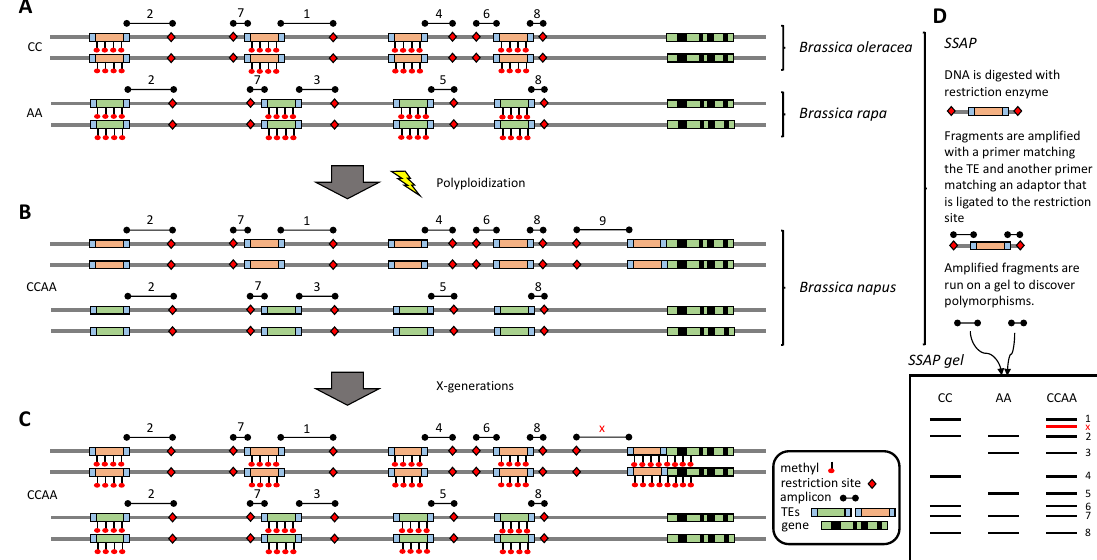
Figure 2. Allopolyploidization and its effects on TE epigenetic regulation. The diagram shows the hypothetical outcome of a cross between the diploid genomes of Brassica oleracea (CC genome) and Brassica rapa (AA genome) to produce an allotetraploid ( Brassica napus —CCAA genome). ( A ) Homologous DNA regions of the parent genomes contain four TEs and one gene; the regions present some divergence due to speciation; ( B ) After polyploidization a tetraploid is formed ( B. napus ) and methylation is transiently suppressed, allowing TEs to move to new genomic locations. In this example just one TE moves to the promoter region of the depicted gene of the CC subgenome; ( C ) After a variable number of generations methylation is reinstated and the novel TE insertion silences the gene in the CC subgenome, but the homeologous gene in the AA subgenome expresses normally; ( D ) In the original experiment [52], SSAPs (Sequence-Specific Amplification Polymorphisms) [75] were used to detect sequence polymorphisms from transposable element insertions in the two parents and the synthesized allotetraploid. In SSAP DNA is digested with a restriction enzyme, and amplicons are generated from one primer binding the TE and a second primer binding an adapter ligated to the restriction site, resulting in a pattern of bands when run on an electrophoresis gel. The gel diagram shows the putative pattern of bands from the hypothetical parental genome sections and the resulting allopolyploid. The different amplicons corresponding to these bands can be followed in sections A to C of the figure (common bands with the same size have the same number). The novel insertion of a TE in the CC subgenome of B. napus generates band x, which constitutes a non-additive band supporting an event of transposition during